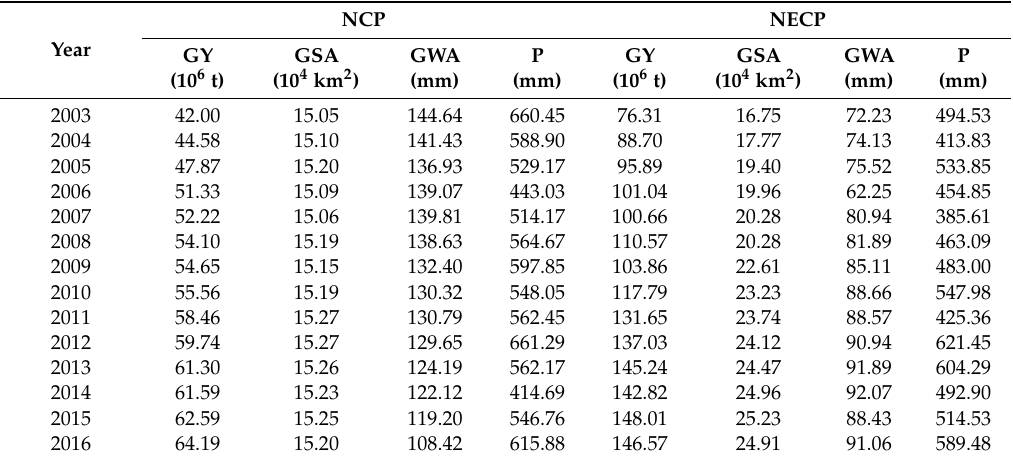
Figure 9. The annual time series of grain production, total sown area of grain crops, and groundwater abstraction in ( a ) the NCP and ( b ) the NECP from 2003 – 2016. Table 3. Annual grain yield (GY), grain sown area (GSA), groundwater abstraction (GWA) and precipitation (P) in NCP and NECP from 2003 to 2016.